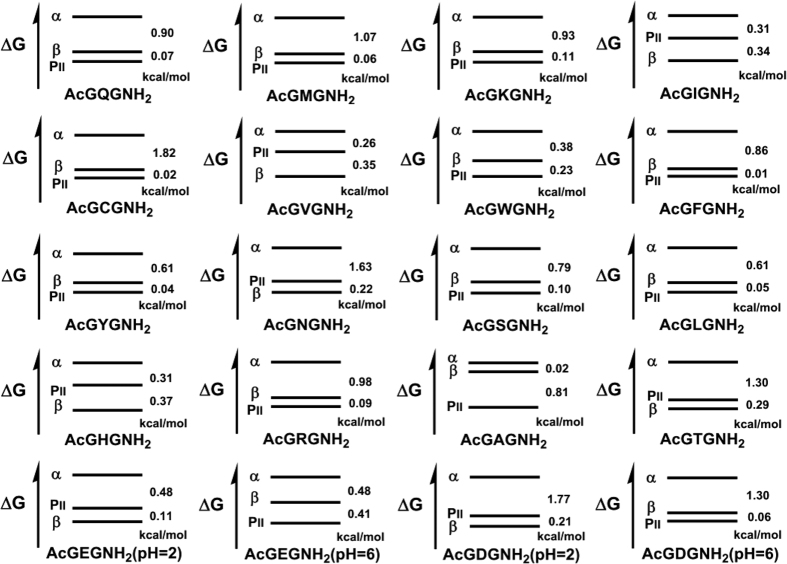
Derived free energy-conformation diagrams for AcGXGNH2.